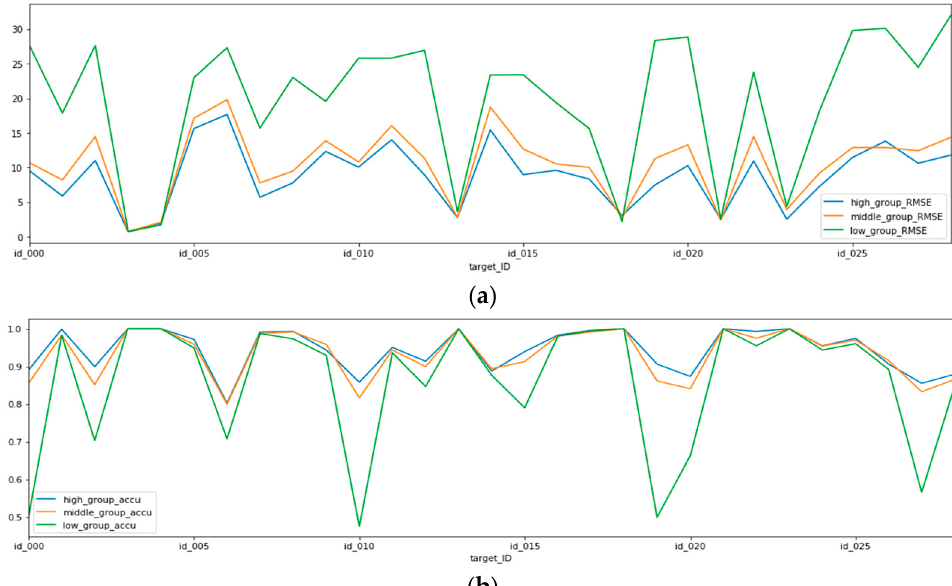
Figure 6. The average RMSE results of the high, middle, and low correlation groups for scenario three. (a) the RMSE averages in the low, middle, and high correlation groups for each space; (b) the average grade accuracies of each group in each space.